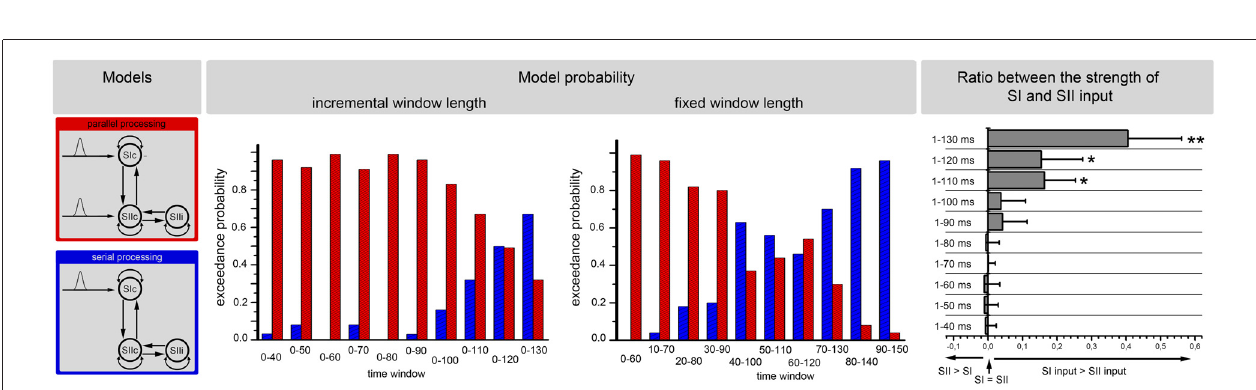
FIGURE 6 | DCM. The figure shows the results of the Bayesian model selection (BMS). The four model structures are illustrated in the upper part of the image (A–D) . These four models were compared by the BMS. This model comparison was performed by estimating the exceedance probabilities (EP) for each model. The EP is a measure of the likelihood that one model is more likely than any other model. The model comprising a conversion from initially parallel to serial processing (second model from left/blue) was the most probable model in each time window.